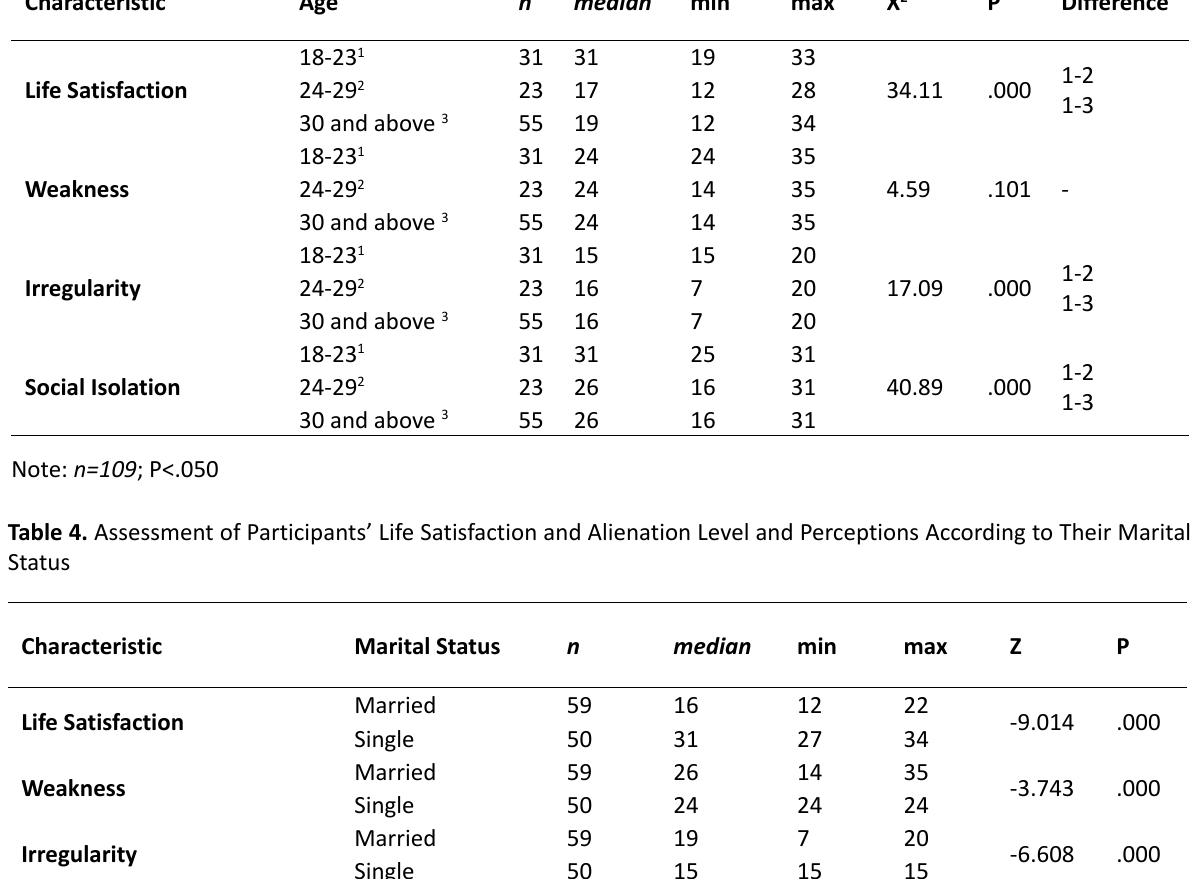
Table 3. Assessment of Participants’ Life Satisfaction and Alienation Level and Perceptions According to Their Age Characteristic